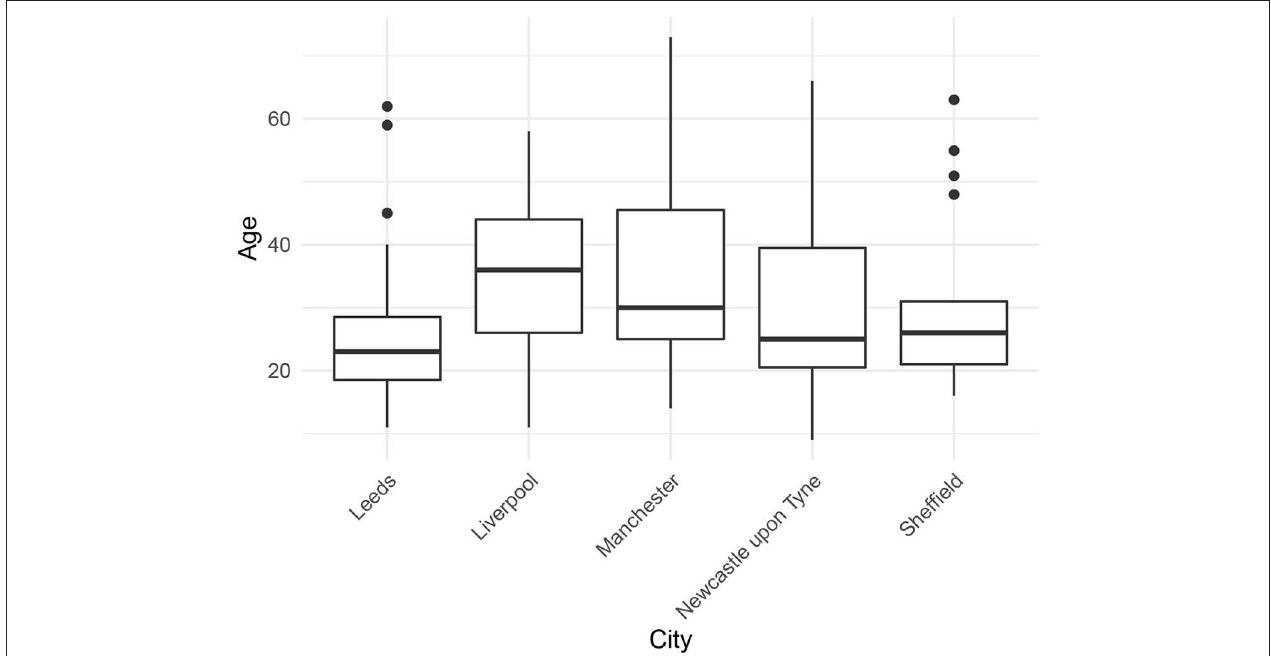
FIGURE 2 | Speaker age by